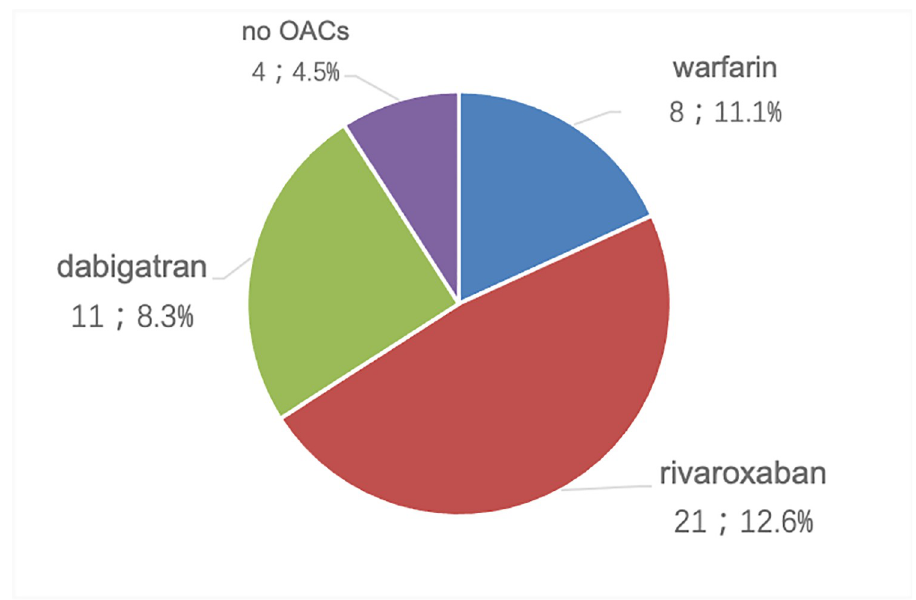
Fig 1. Proportion of bleeding events in patients with